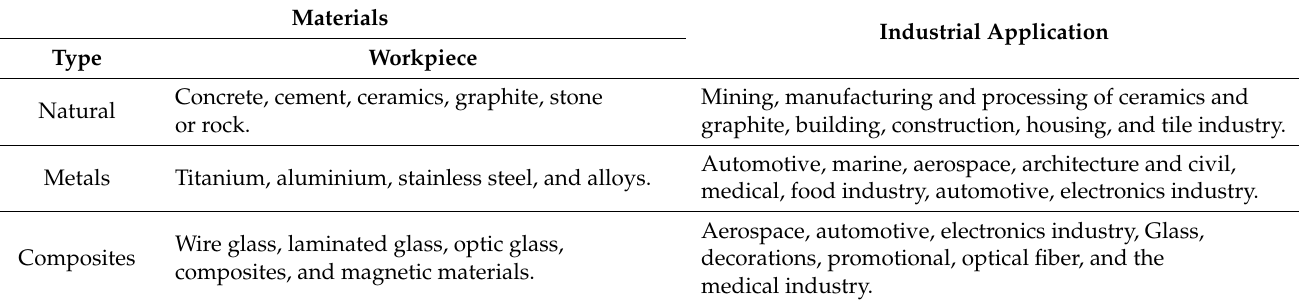
Table 2. AWJM materials and areas of application